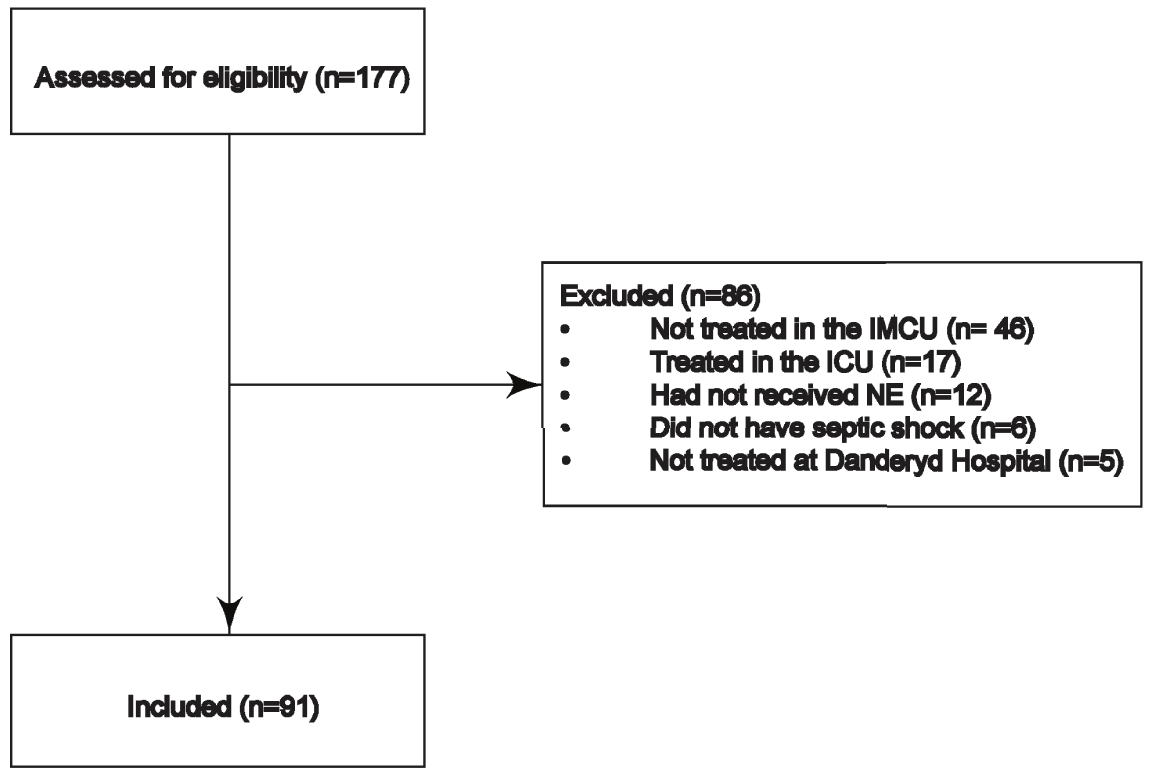
Fig 1. Consort chart. Consort chart showingpatients eligiblefor the study and reasonfor exclusion.IMCU = Intermediate Care Unit, ICU = Intensive Care Unit, NE = Norepinephrine.